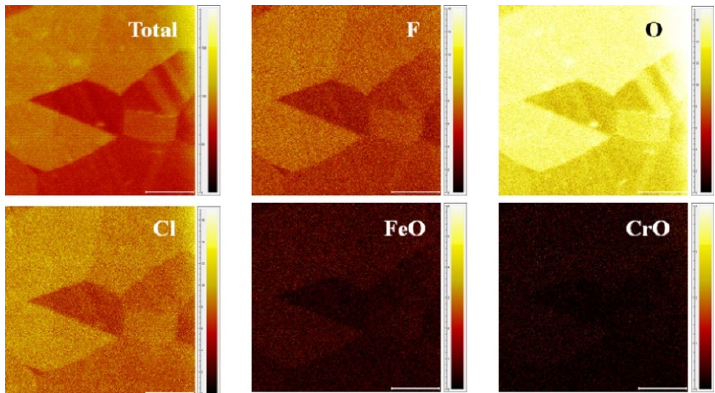
Figure 4. ToF-SIMS negative ions 2D-mapping of the sample (Scale bar: 100 μ m).